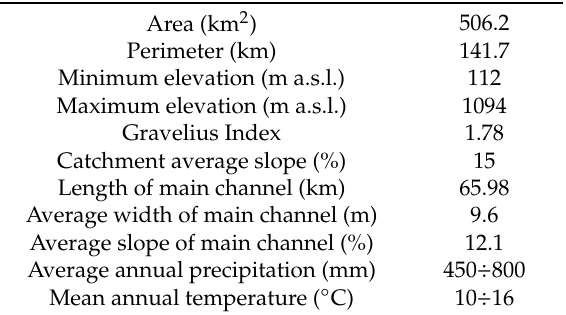
Table A1. Morphologic features of Carapelle catchment.